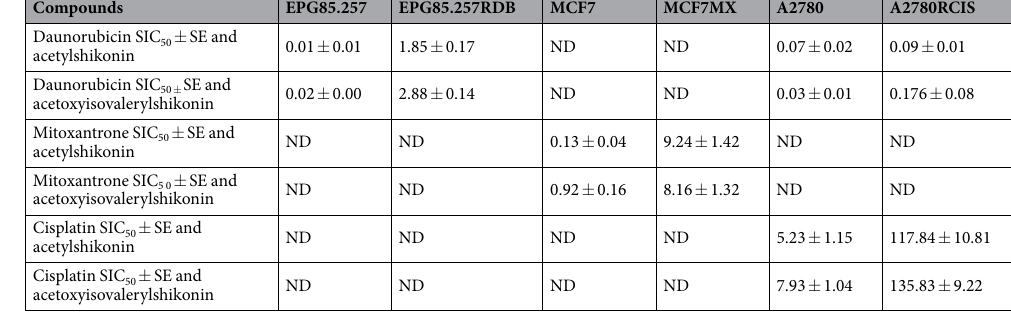
Table 2. Synergistic toxicity of standard chemotherapeutics agent on the cancer cells cotreated either with acetylshikonin or acetoxyisovalerylshikonin. a Daunorubicin, Mitoxantrone, or cisplatin concentrations ( µ M) required for 50% inhibition of cell growth after 5 days of drug exposure. Data represent the mean ± standard error of three distinct tests. ND, not